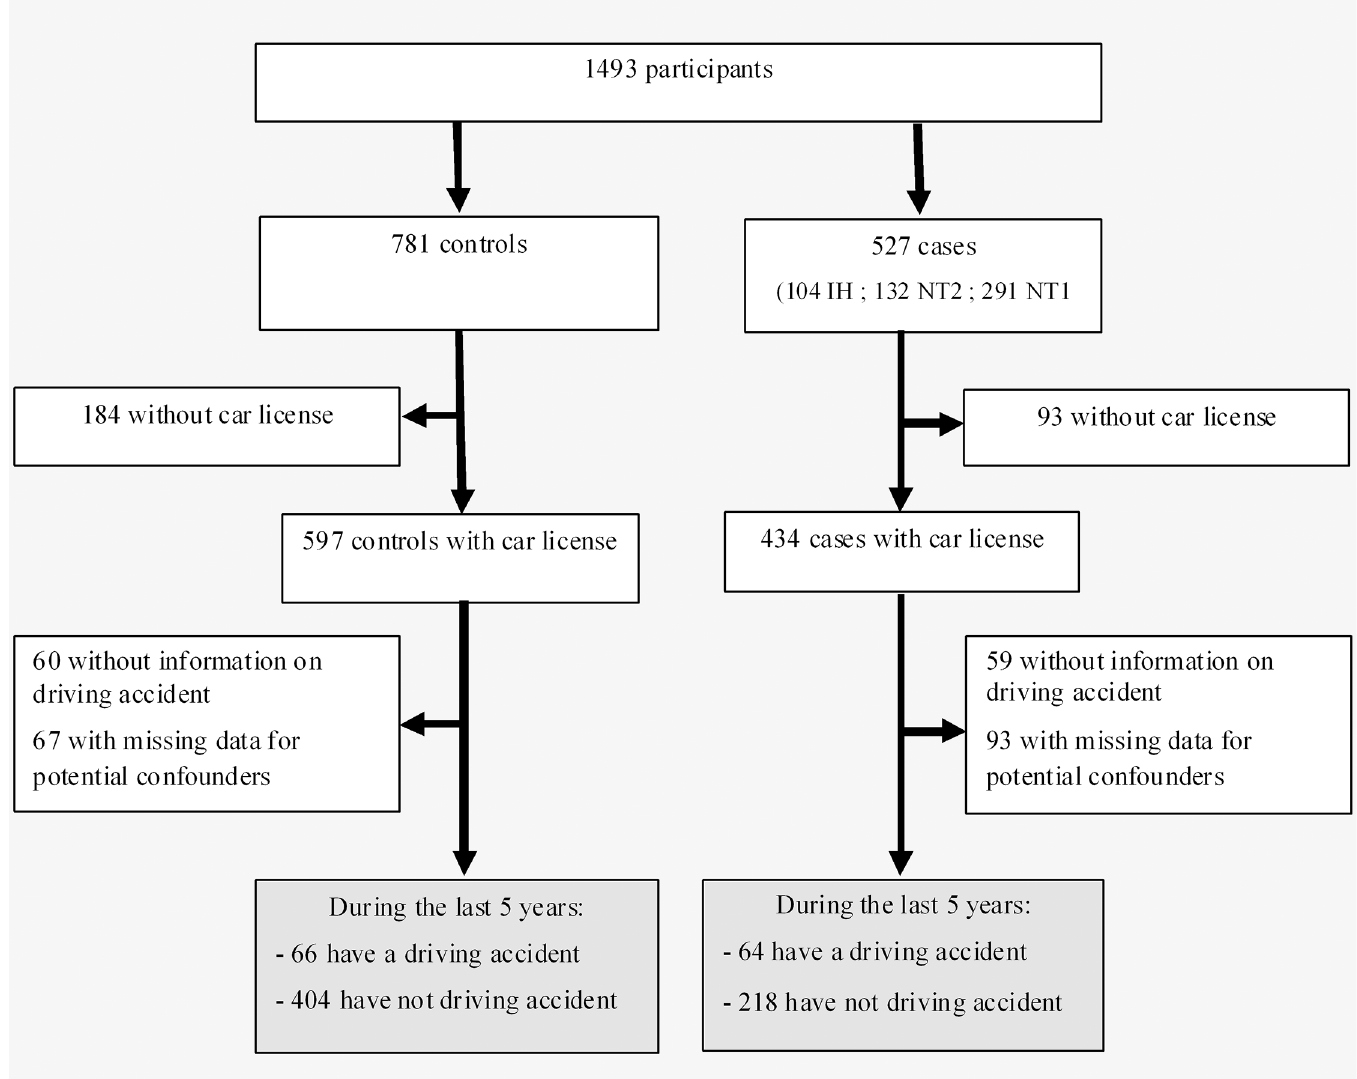
Fig 1. Flow chart of patients and healthy